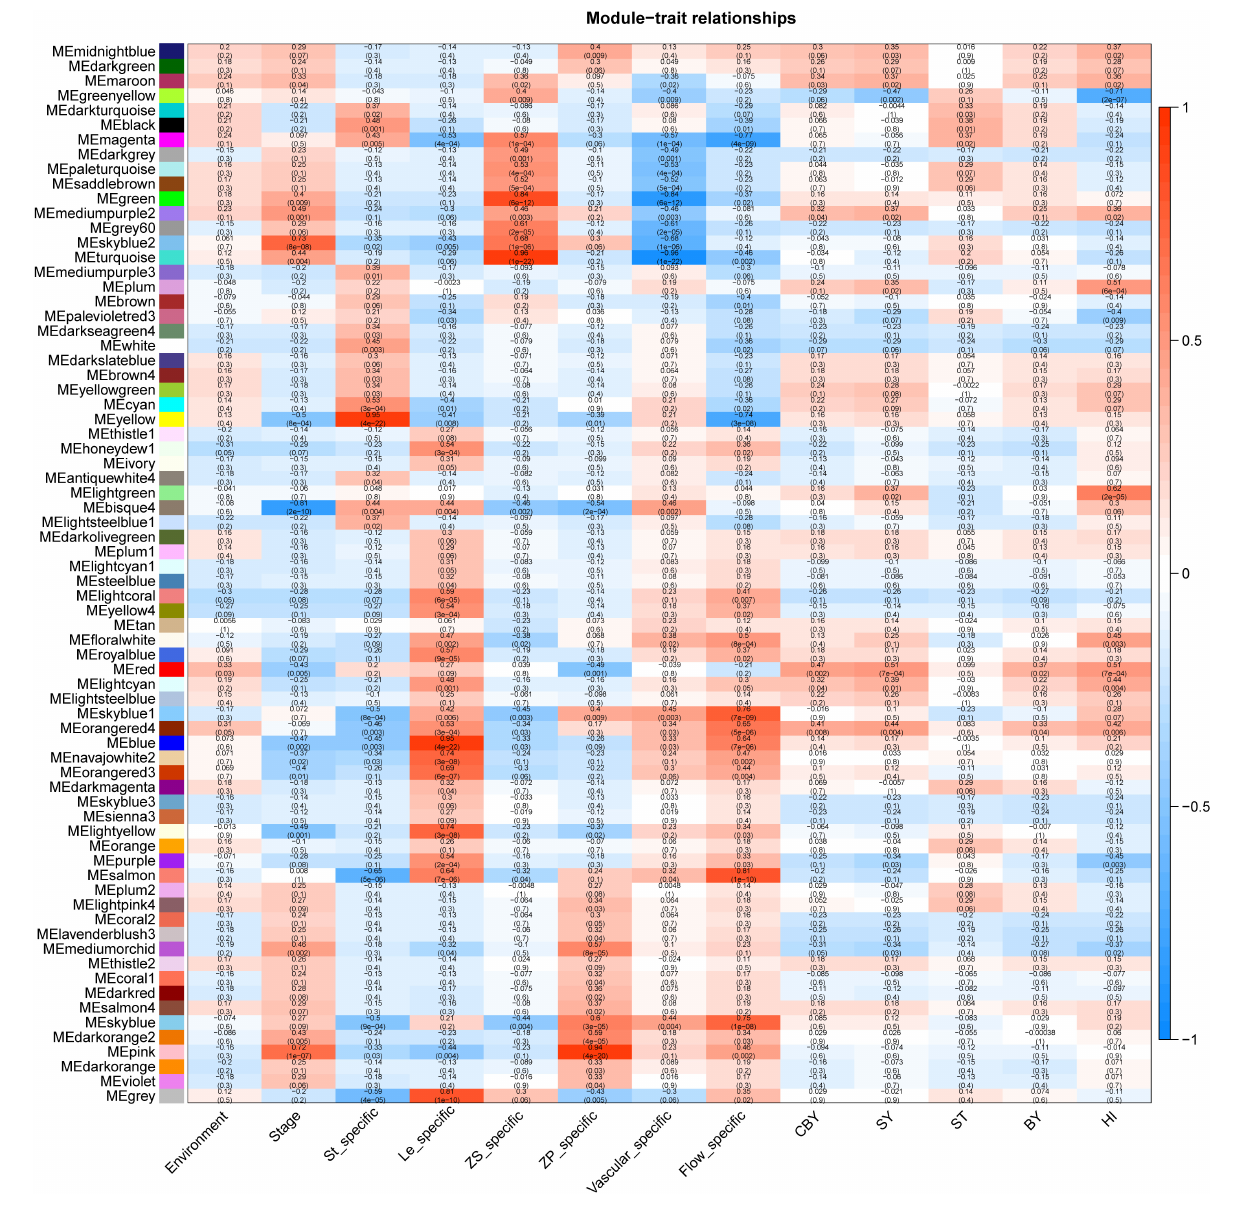
FIGURE 3 | An overview of module and traits corresponding through